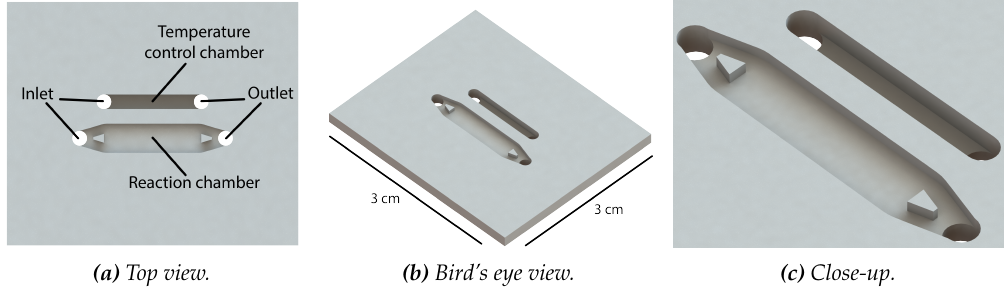
Figure 3. The SolidWorks design of the DNA amplification chip with reaction chamber and chamber for thermocouple-assisted real-time temperature monitoring. This drawing is used to set up the code for the CNC mill. Total size of the chip is 3 cm by 3 cm. Panel ( a ) shows the top view, panel ( b ) shows the bird’s eye view, and panel ( c ) the close-up of the chambers with the in-chamber trapezoid